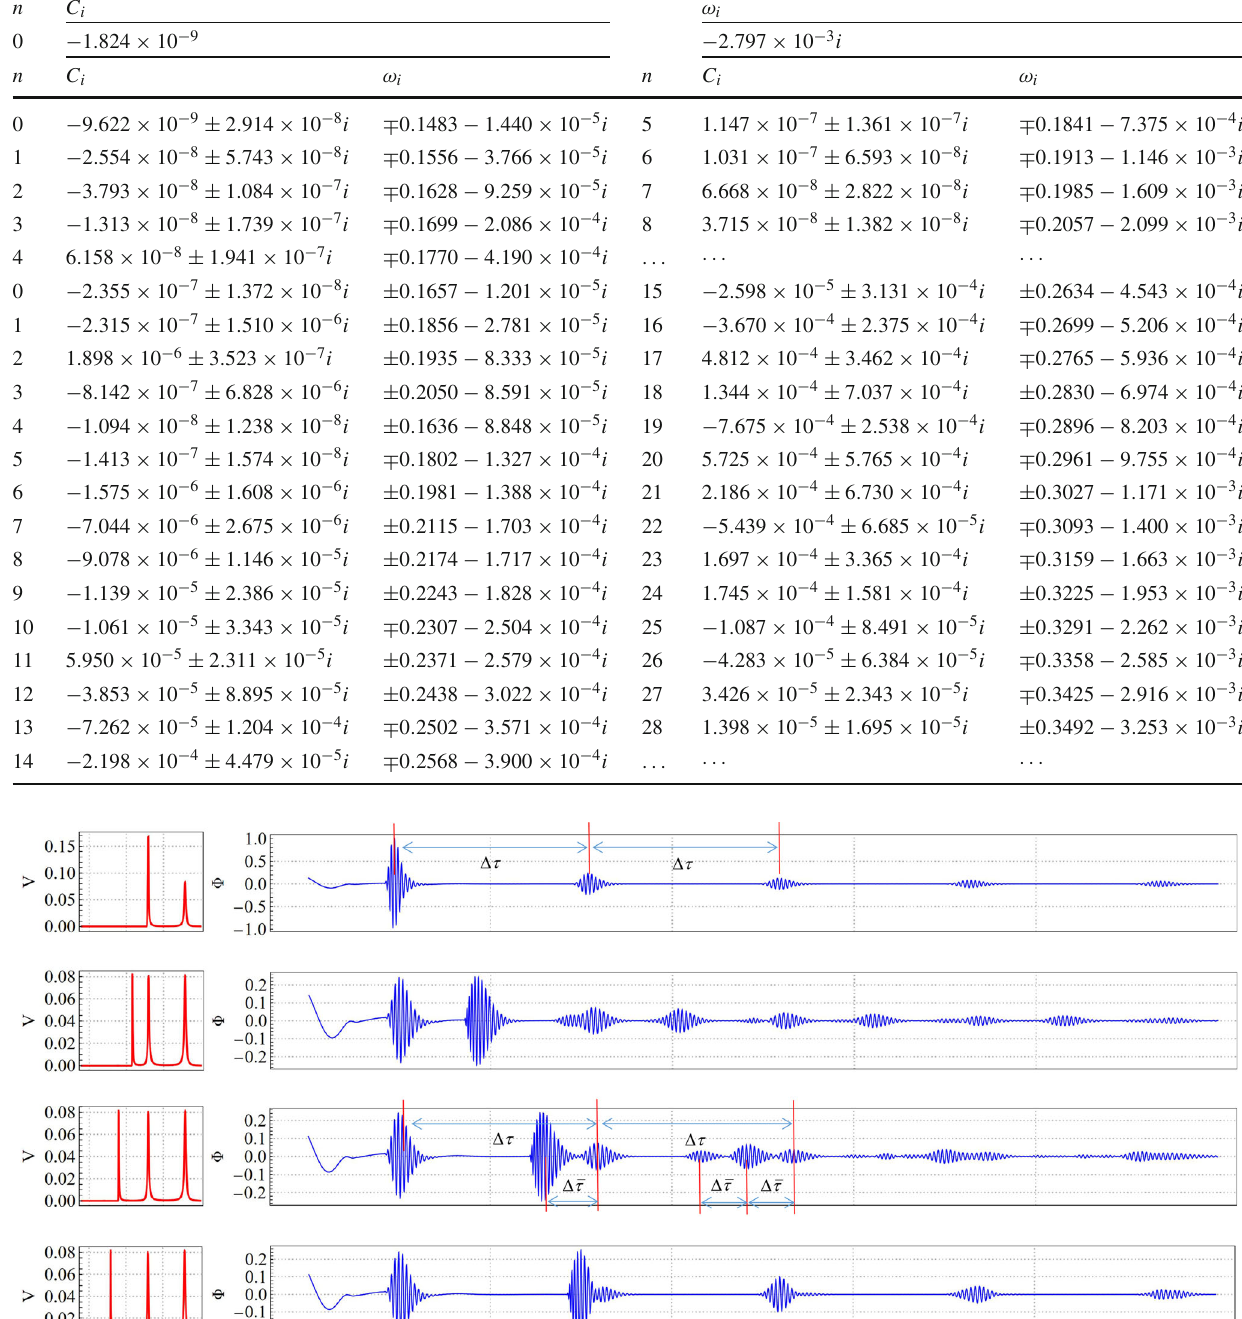
Table 1 The quasinormal frequency ω i and its corresponding coefficient C i at t 0 = 4000 of the three profiles in Fig. 2. And the first column of the table is the overtone number n